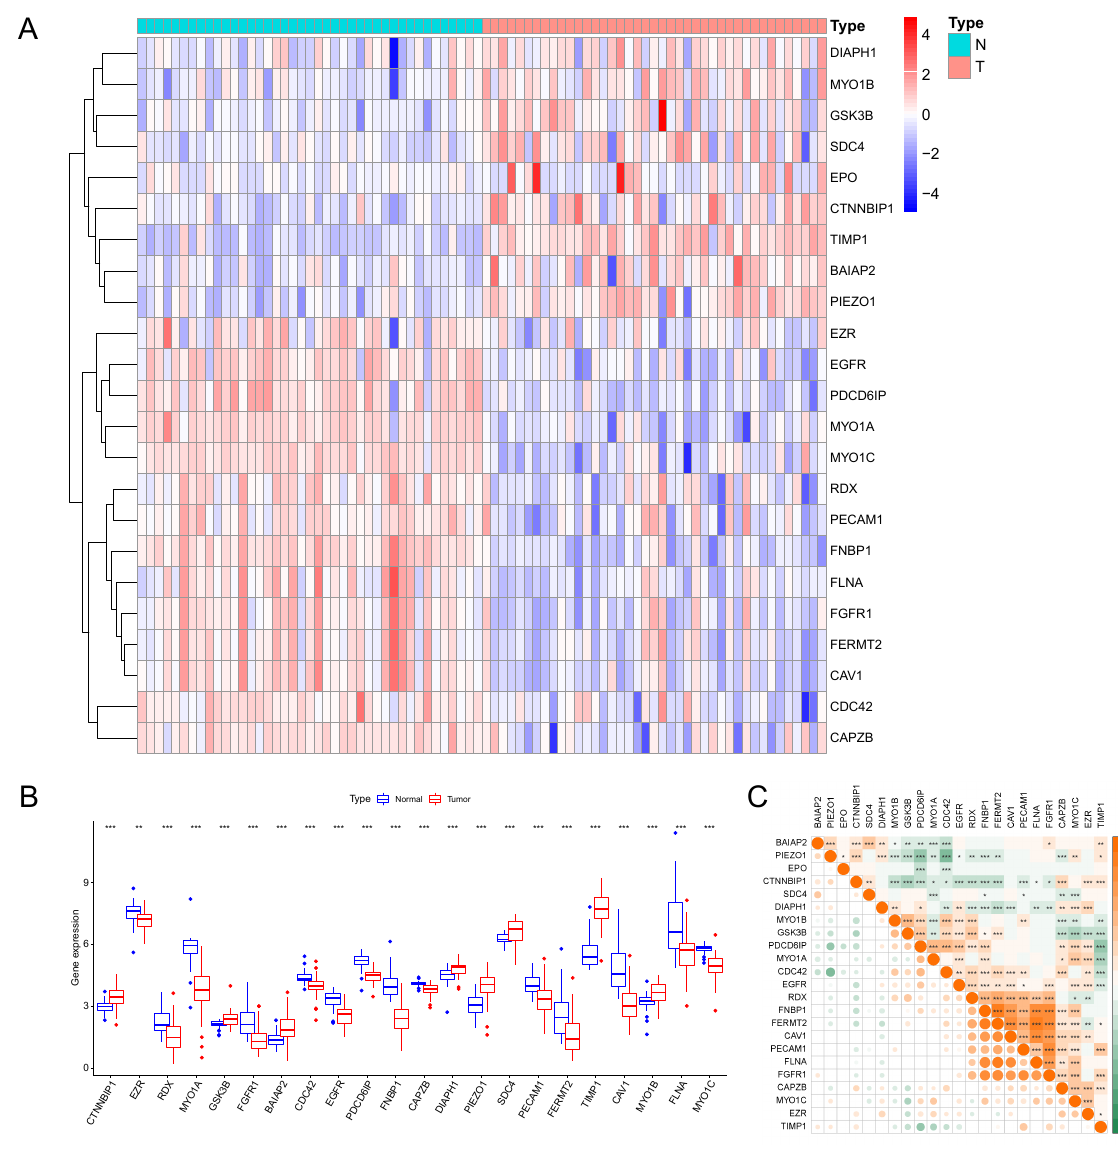
Figure 2. Differentially expressed MTRGs in COAD tissues compared with normal colon tissues and their interactions. ( A ) Heatmap of the expression of the 23 MTRGs in the tumors and normal tissues of the TCGA dataset. ( B ) The expression of MTRGs was significantly different in 41 COAD compared with the normal colon pairs. ( C ) Interaction analysis among the 23 MTRGs. * p < 0.05, ** p < 0.01, *** p <